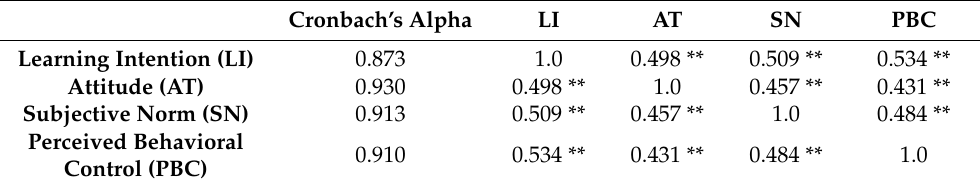
Table 4. Reliability and correlation between constructs of the